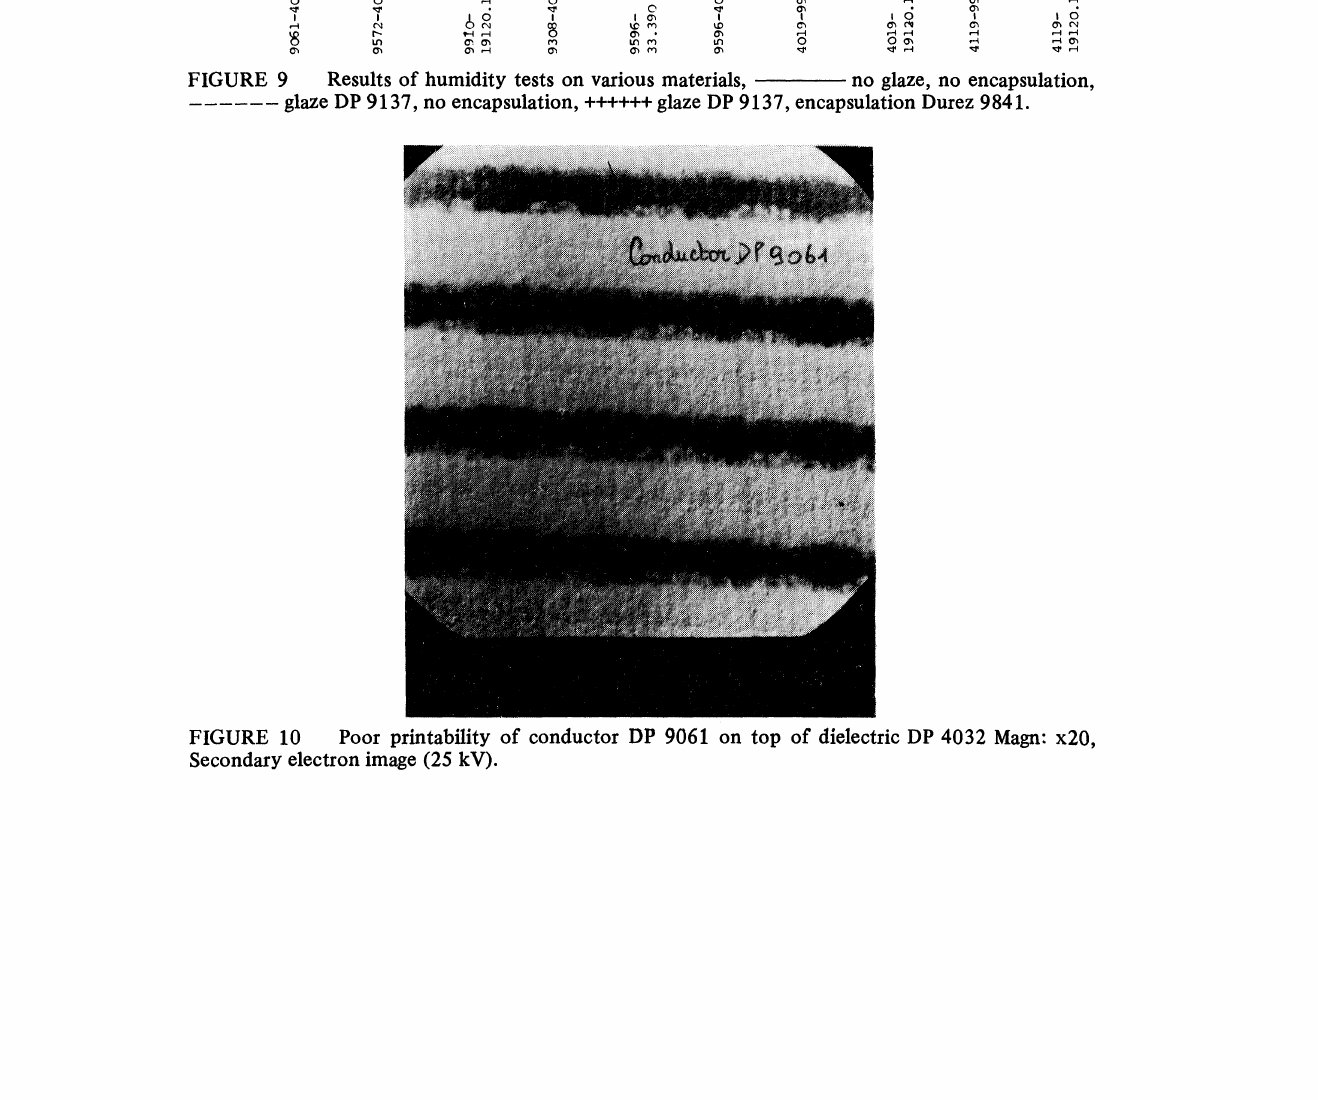
FIGURE 9 Results of humidity tests on various materials,